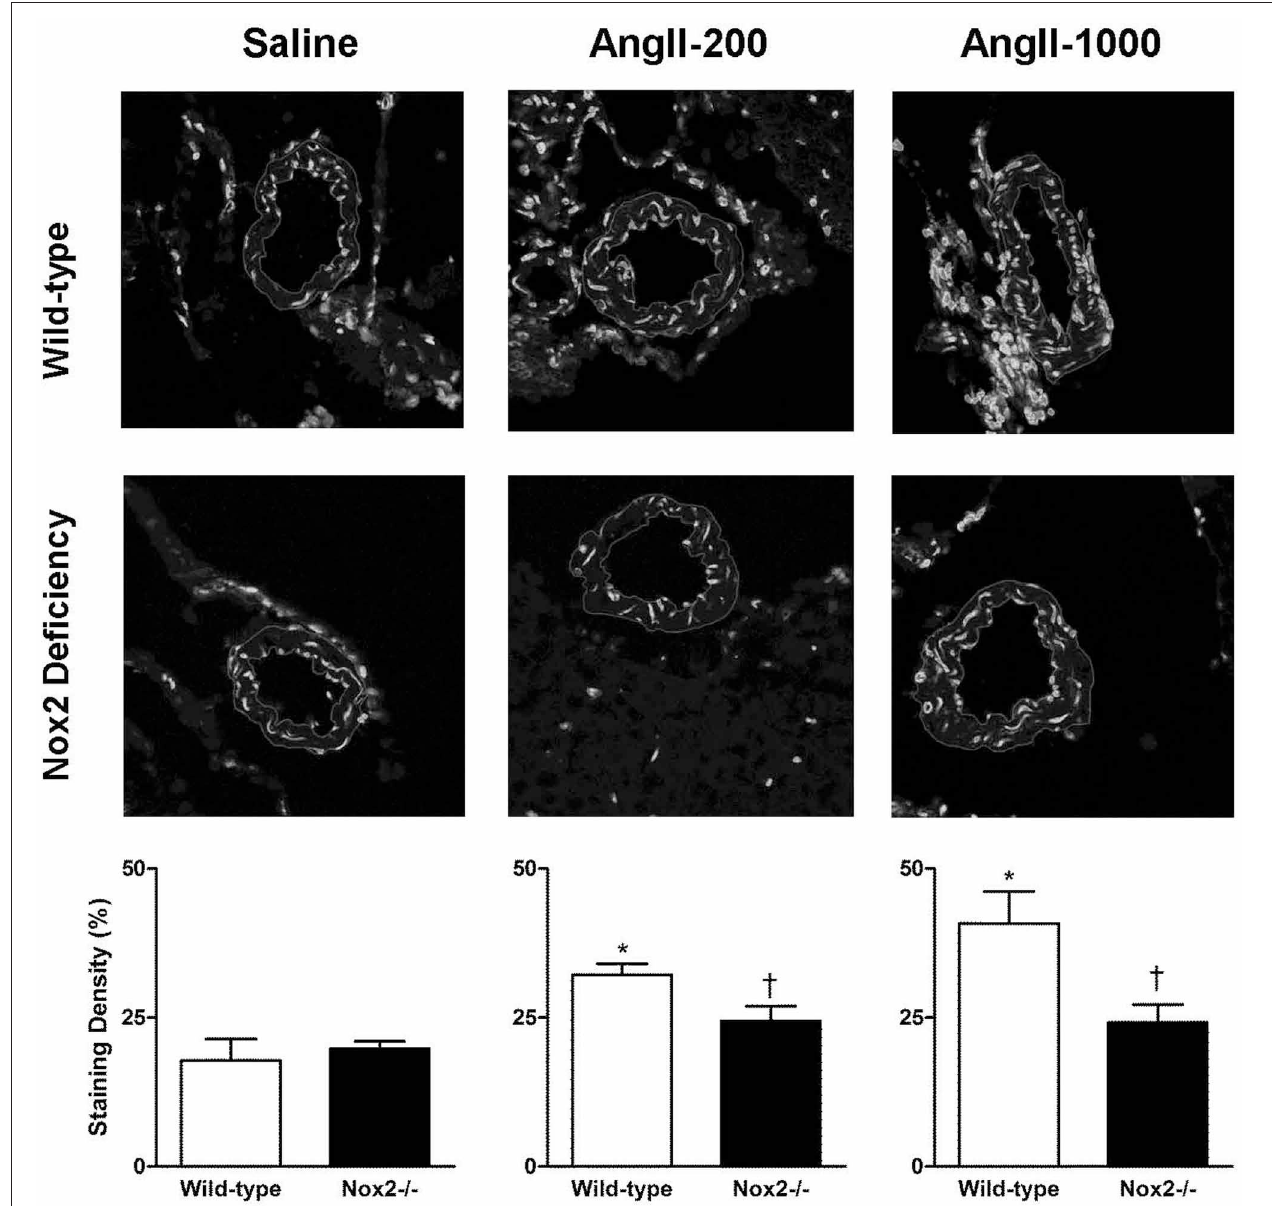
FIGURE 1 | Representative confocal fluorescent sections (inner and outer edges of cerebral arterioles are highlighted) and relative fluorescence in cerebral arterioles in wild-type (WT) and Nox2-deficient ( − / − ) mice